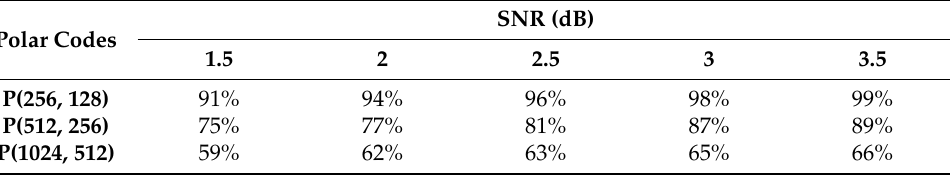
Table 3. Output (i.e., frequency and event α ) of the preprocessing genie-aided BP flip decoder for 10 7